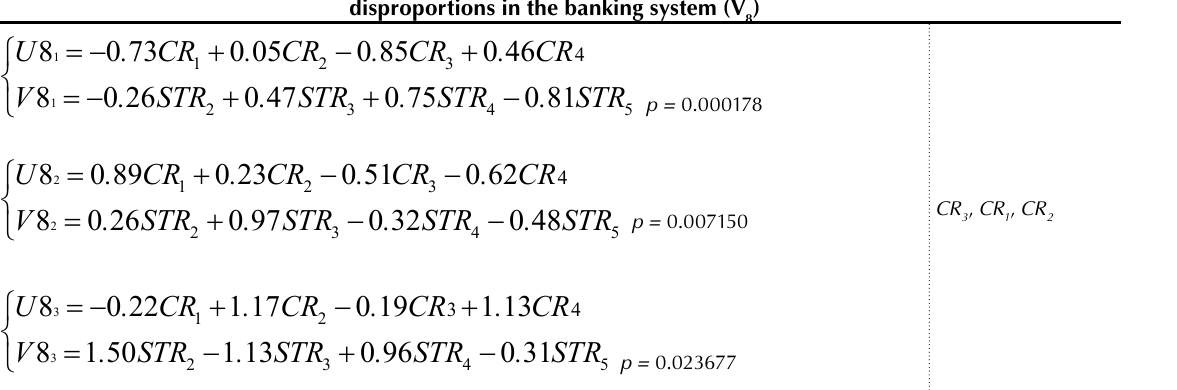
Indicators for assessing the foreign exchange regulation effectiveness and structural changes (U